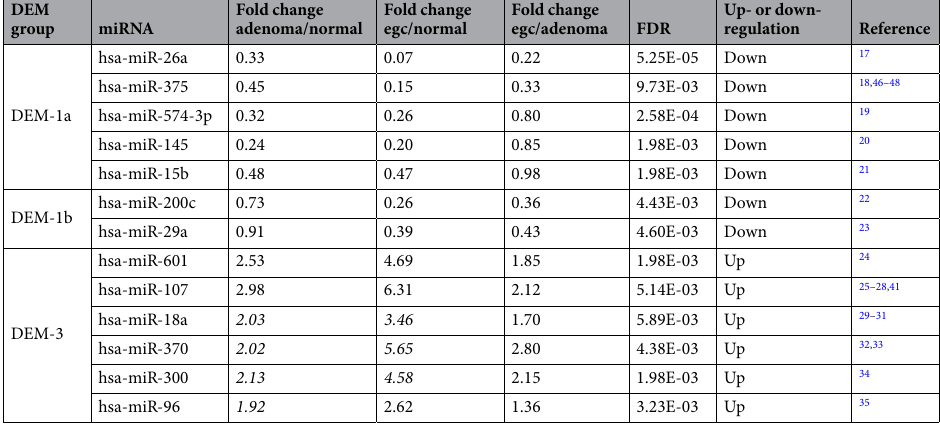
Table 2. Differentially expressed miRNAs showing identical patterns as in the previous miRNA